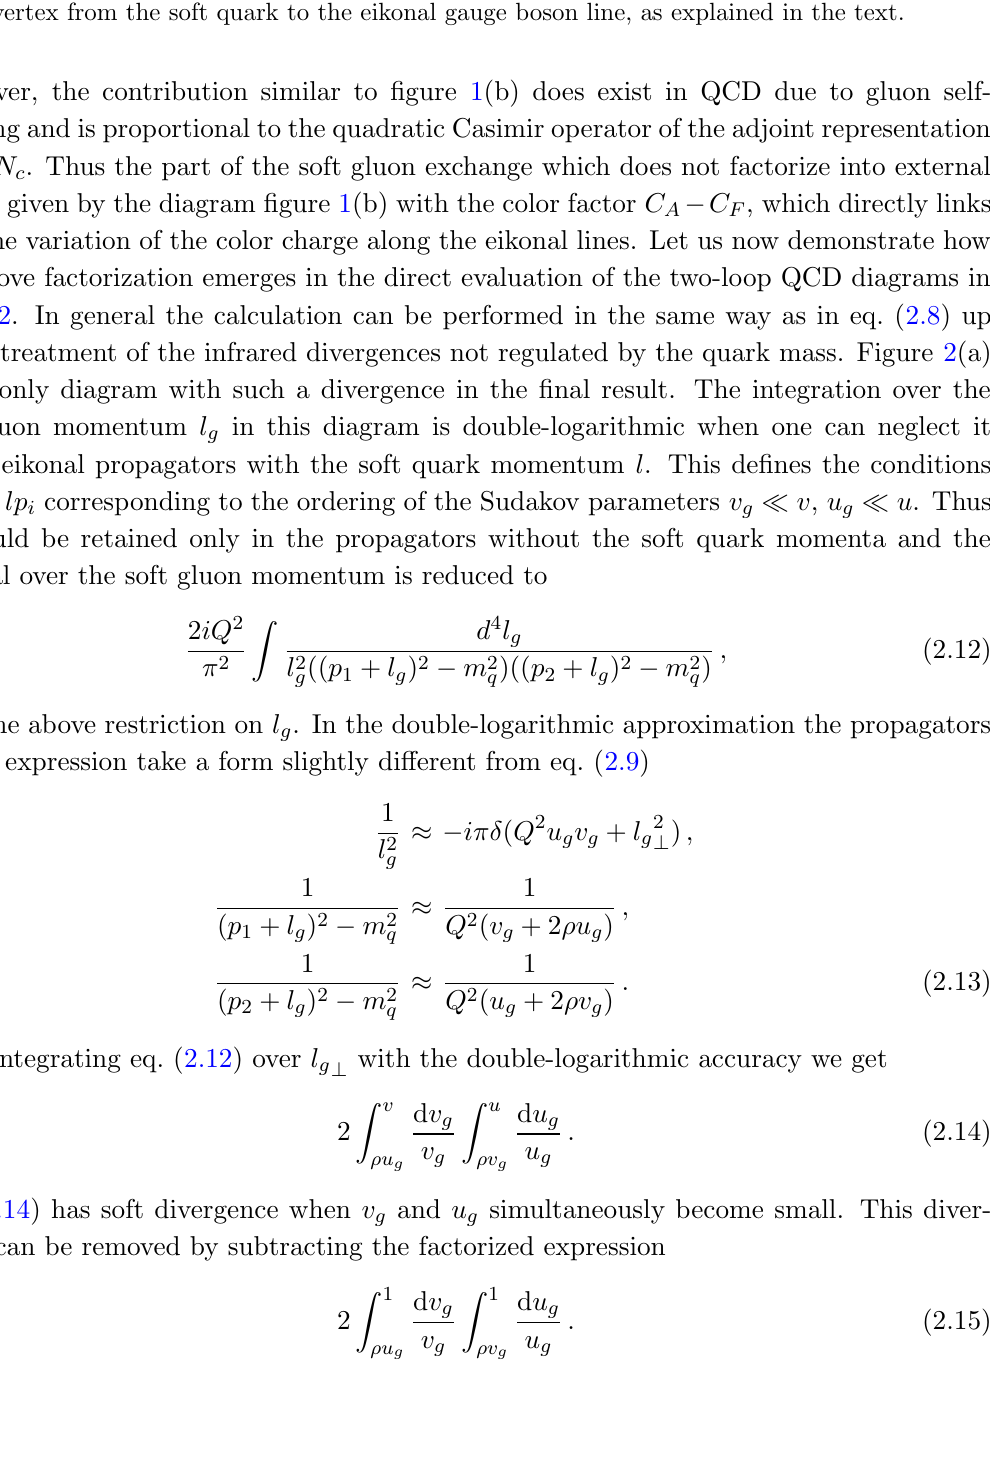
Figure 3 . Diagramatic representation of the sequence of identities which move the soft